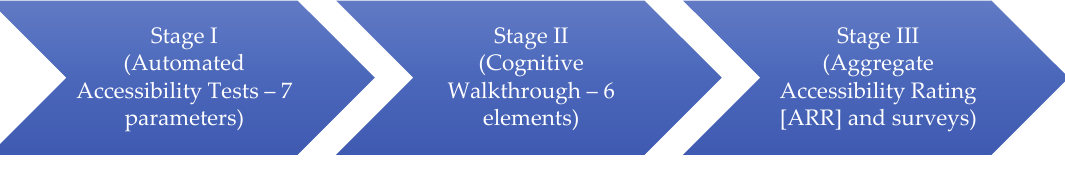
Figure 3. Research stages. Source: Own work. Table 1. Tools used for automated accessibility testing.